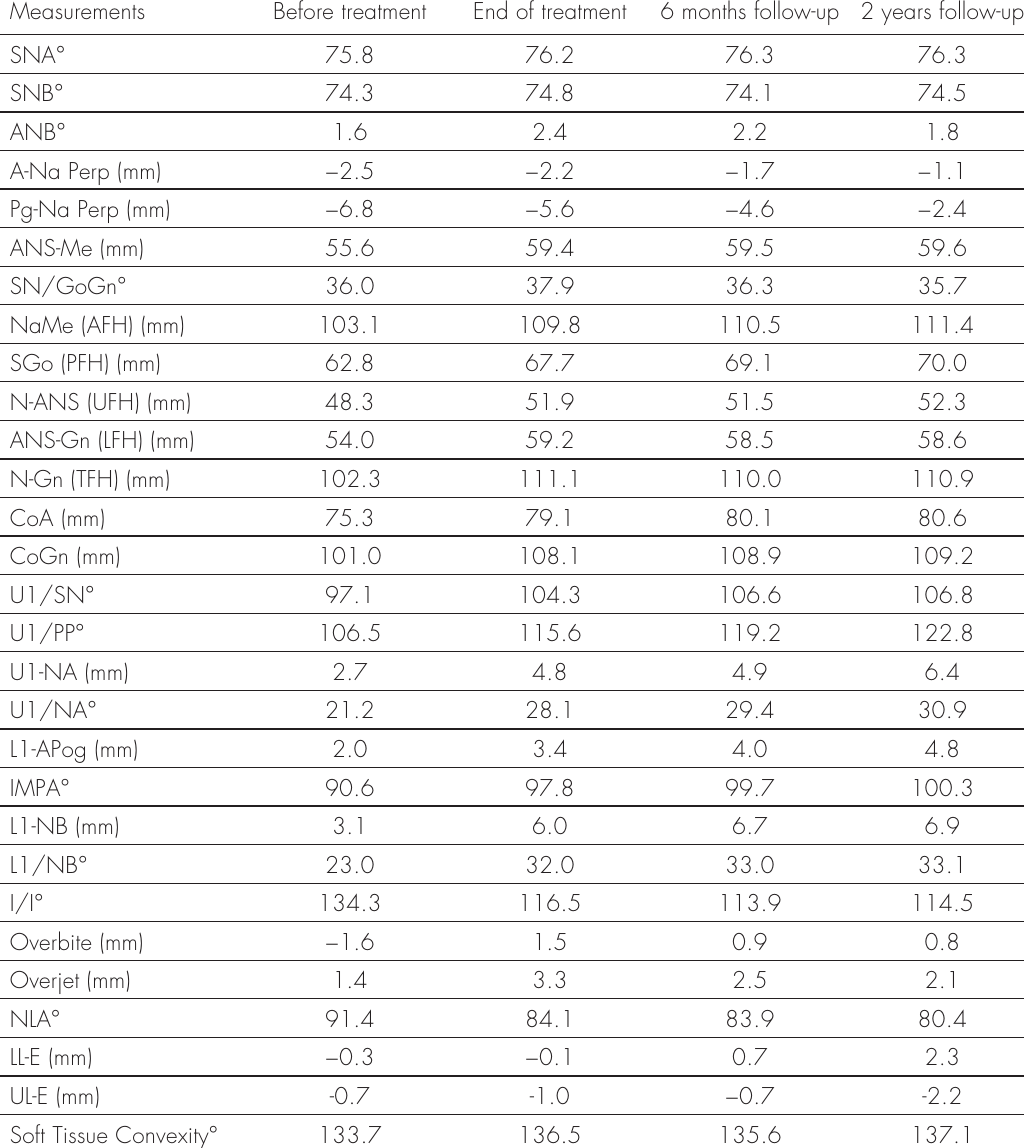
Table I. Cephalometric measurements of the patient who was treated and followed up. Measurements Before treatment End of